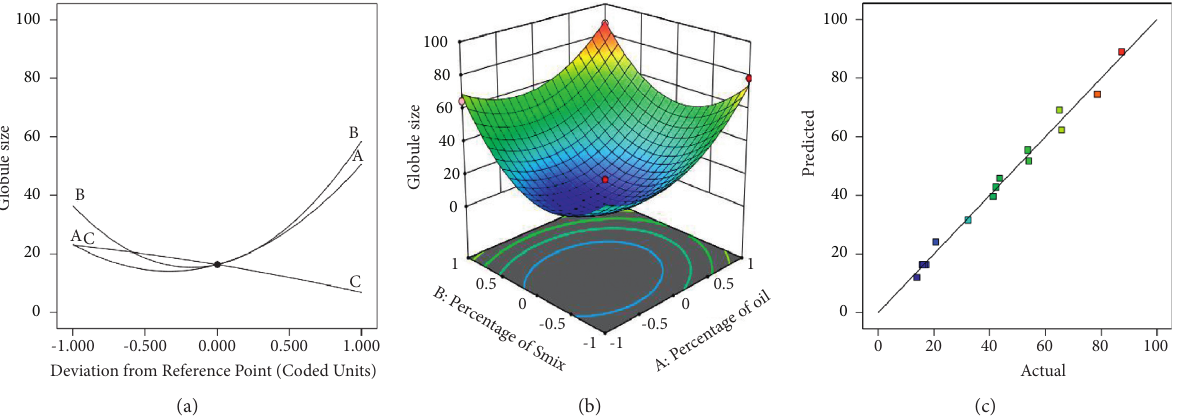
Figure 1: Consequence of independent variables on globule size. Results were presented in the (a) perturbation plot, (b) 3D surface plot, and (c) predicted versus actual graph.